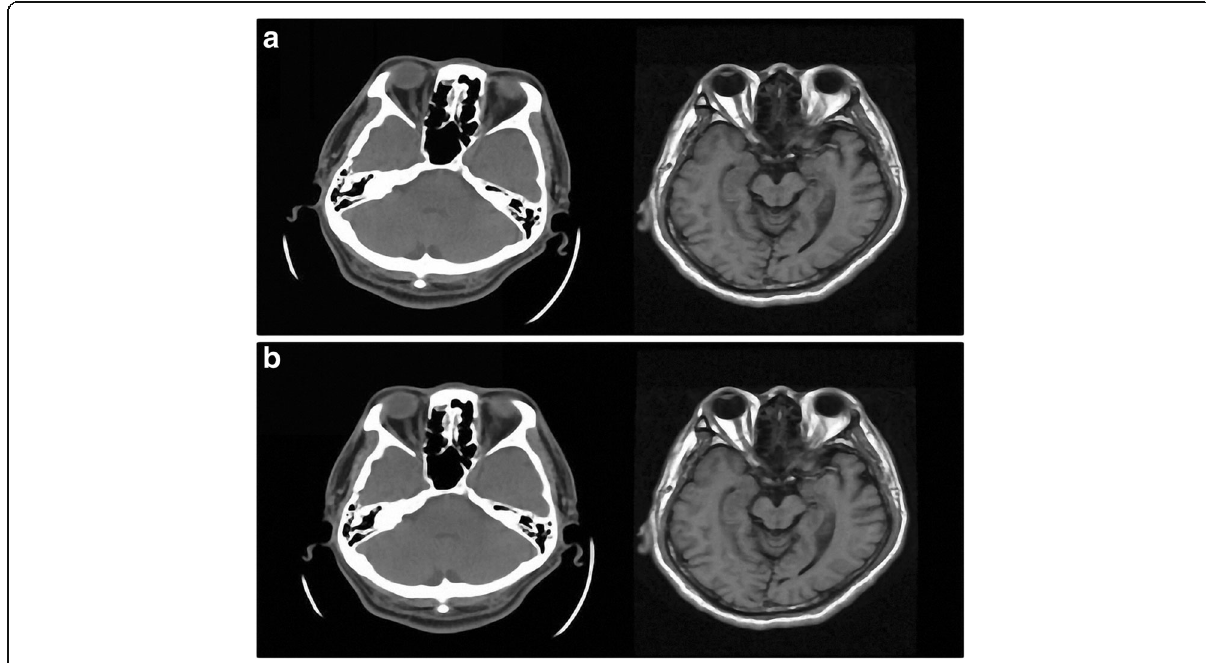
Fig. 10 T1-MRI and CT images of patient 2 taken as an example. a is the original image and b is the registered